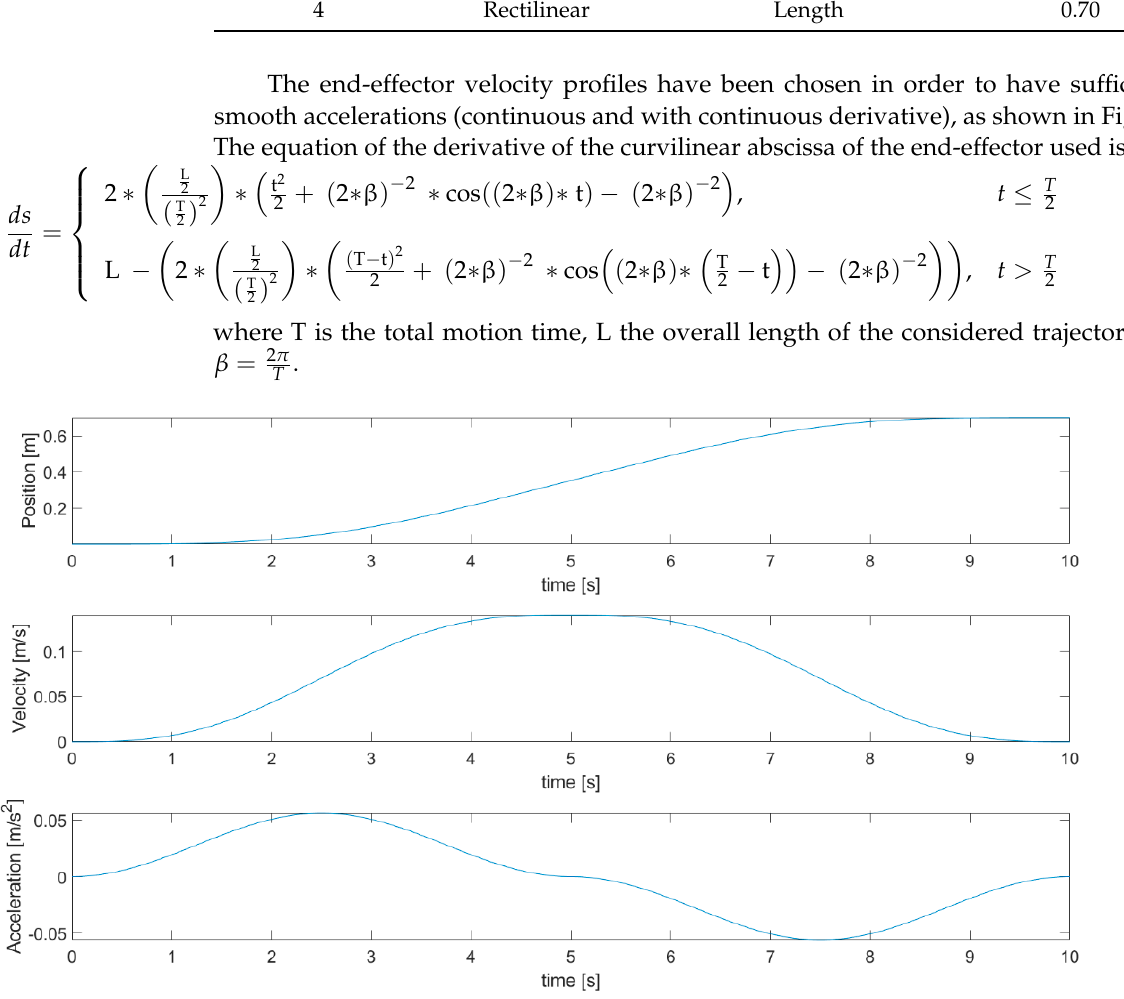
Figure 2. End-effector curvilinear abscissa and its derivatives.